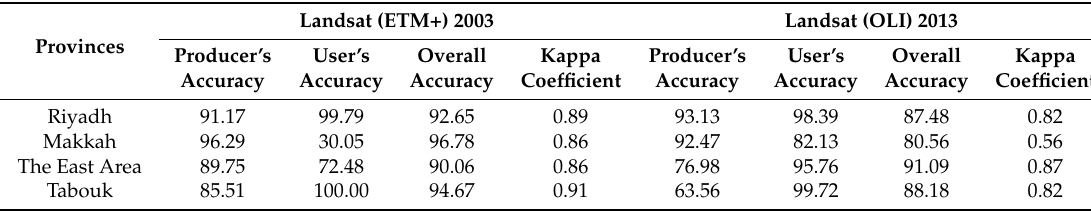
Table 2. Accuracy assessment of